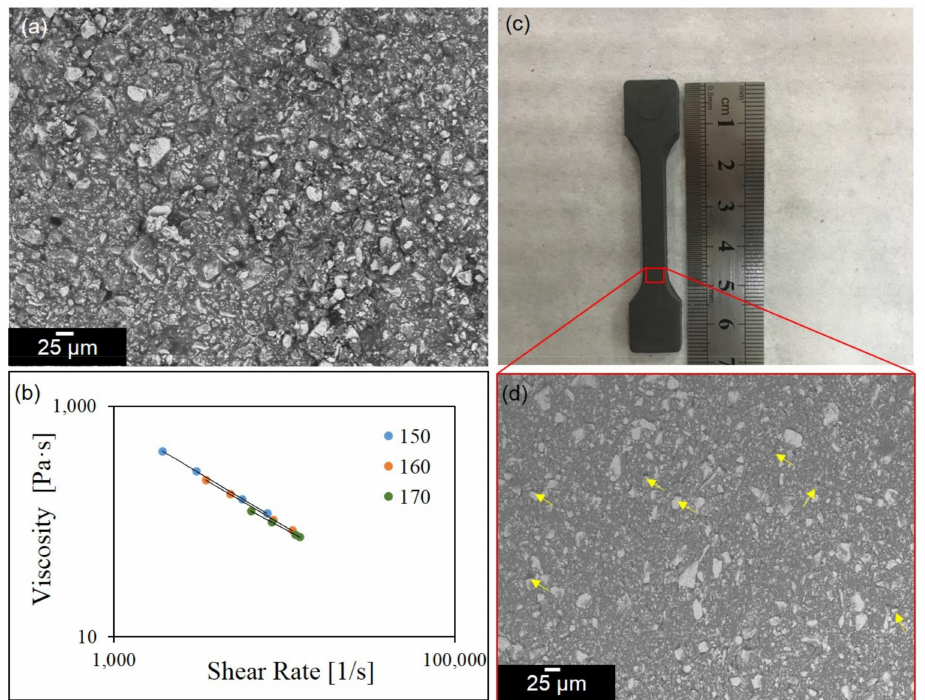
Figure 3. ( a ) SEM image of the feedstock, ( b ) flow behaviour of the feedstock, ( c ) green part and ( d ) SEM image of the green